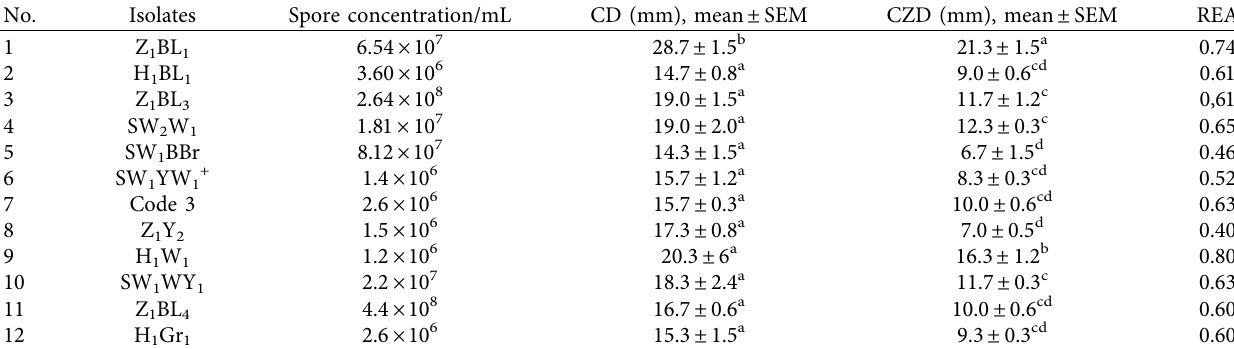
Table 1: Clear zone diameter of fungal isolates on skim milk agar media.